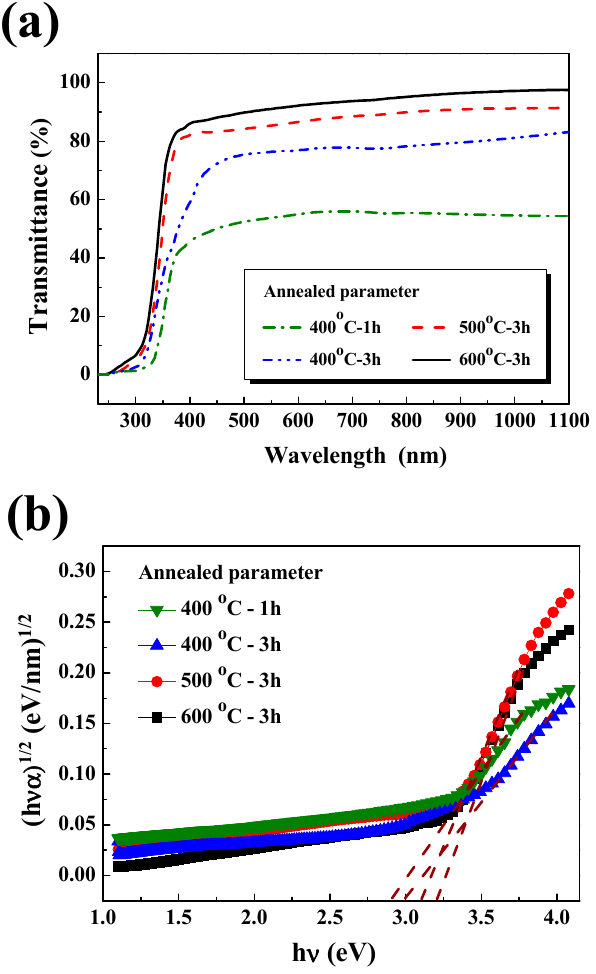
Figure 5. ( a ) Optical transmittance spectra and ( b ) optical bandgap of the L2NiO thin films as a function of annealing temperatures and times.